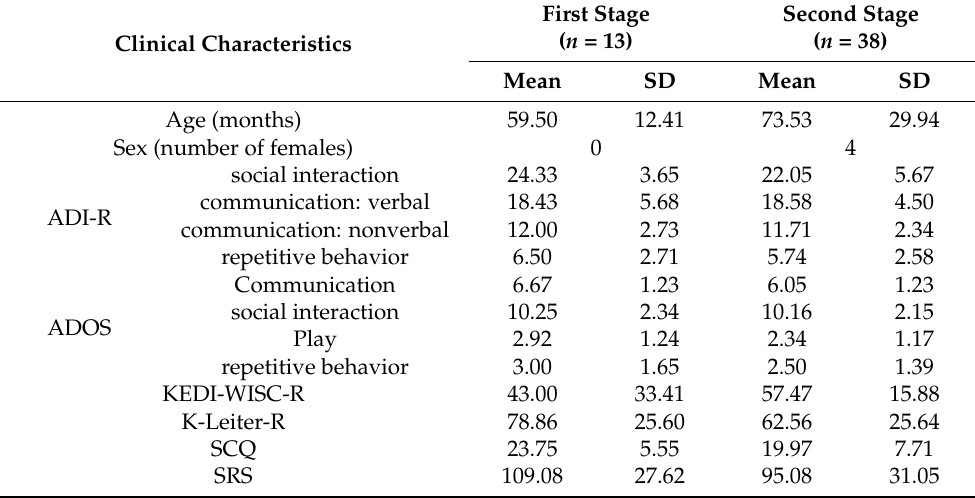
Table 1. Clinical characteristics of probands.